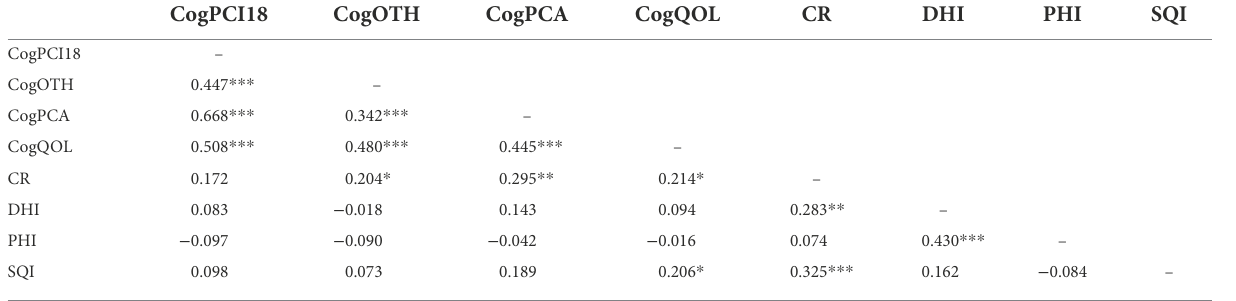
TABLE 3 Correlation table of cognitive and behavioral, psychosocial, and lifestyle variables in BC patients.